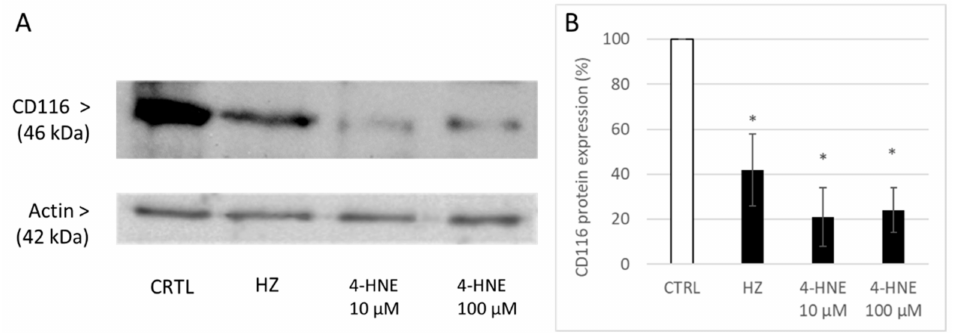
Figure 6. Inhibition of expression of CD116 in whole cell lysate of HZ-fed or 4-HNE-treated mono- cytes. Protein expression of CD116 was analysed in 20 µ g lysate protein from monocytes harvested at day 1 after HZ phagocytosis or 4-HNE treatment. Proteins were separated by one-dimensional SDS-PAGE and Western blotted. Transferred proteins were probed with specific primary anti-CD116 and with anti-actin antibodies, the latter for quality control of transfer and protein load per lane. Bound antibodies were detected by binding of appropriate secondary antibodies and evidenced by ECL. One representative experiment of 3 ( A ) and densitometric analysis ( B ) are shown. Values are referred to controls and expressed as a percentage. Means ± SE of 3 independent experiments from 3 different phagocyte donors are shown. Significant differences are indicated as * p <